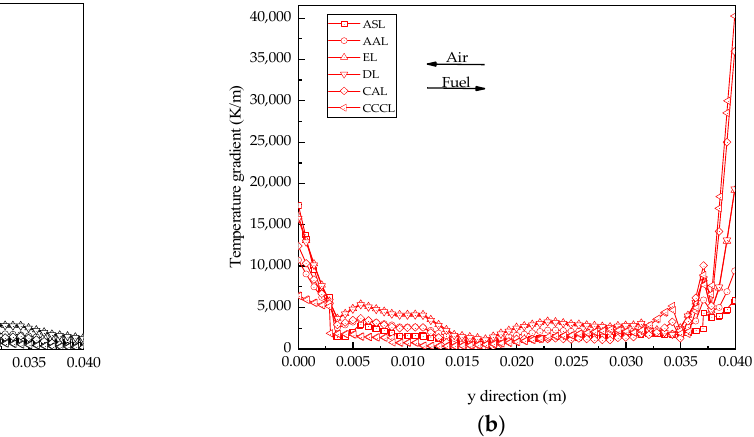
Figure 12. Distribution of temperature gradient of each component along the forward direction of y-axis for case C. ( a ) Co-flow; ( b ) Counter-flow.